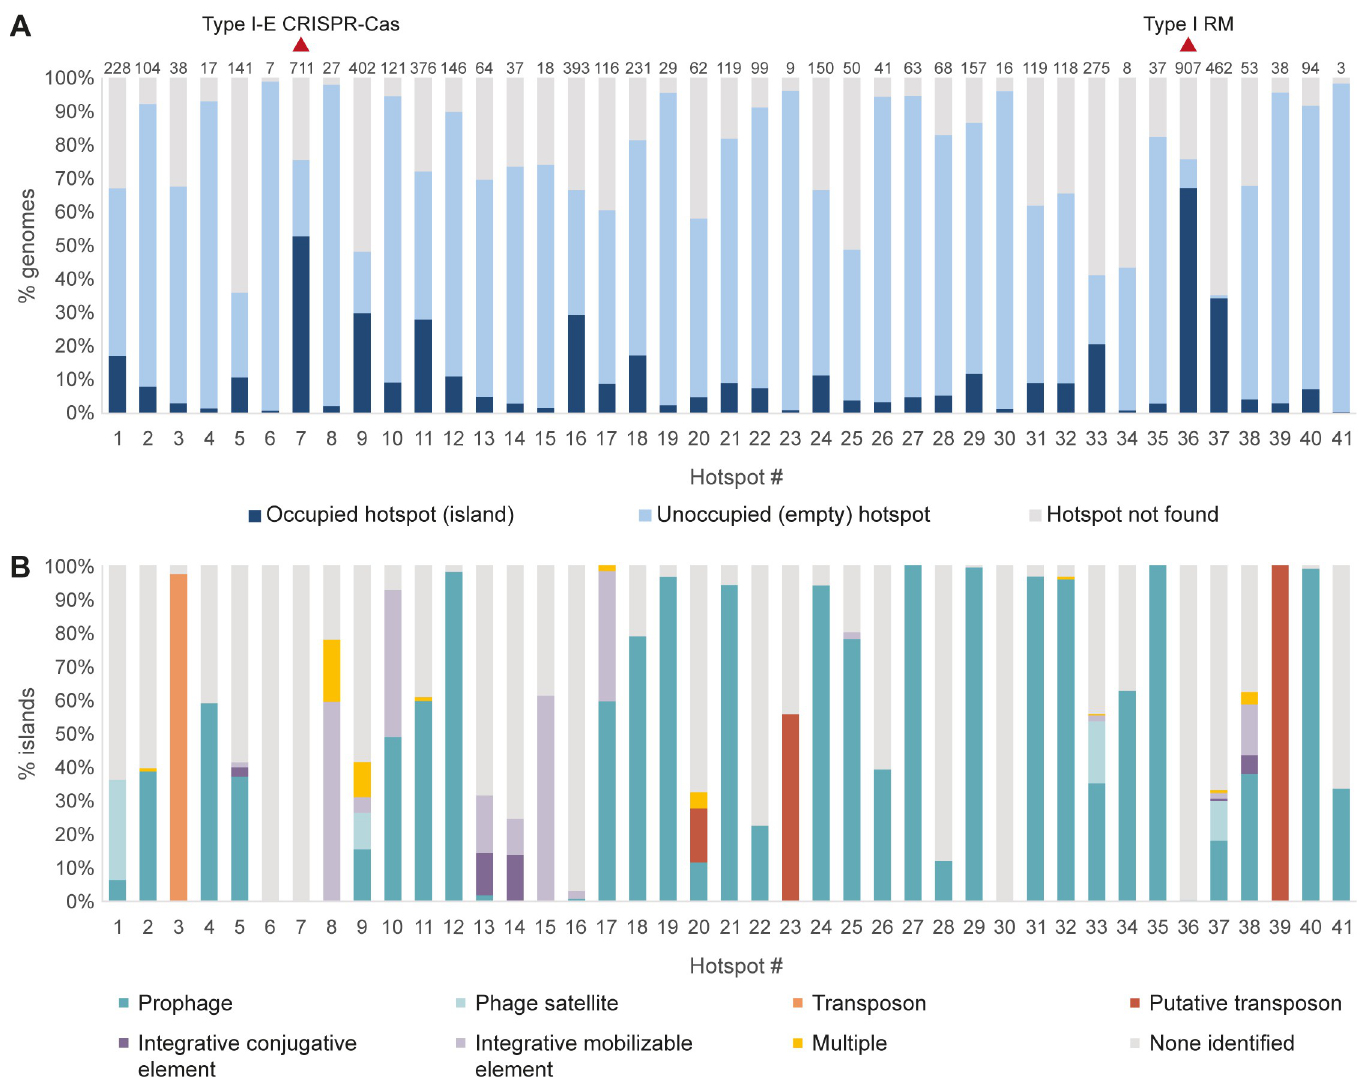
Fig 2. Occupancy of defense hotspots. (A) Bar graph showing the occupancy of each integration hotspot among 1,351 E . coli genomes analyzed. The number above each bar indicates the number of genomes in which the hotspot was found occupied. “Hotspot not found” (gray) indicates that one or both core flanking genes were not found in the relevant genome. (B) Nature of mobile genetic elements (MGEs) integrated at hotspots identified in this study. Multiple, analysis of genes in the integrated element suggests a combination of multiple types of